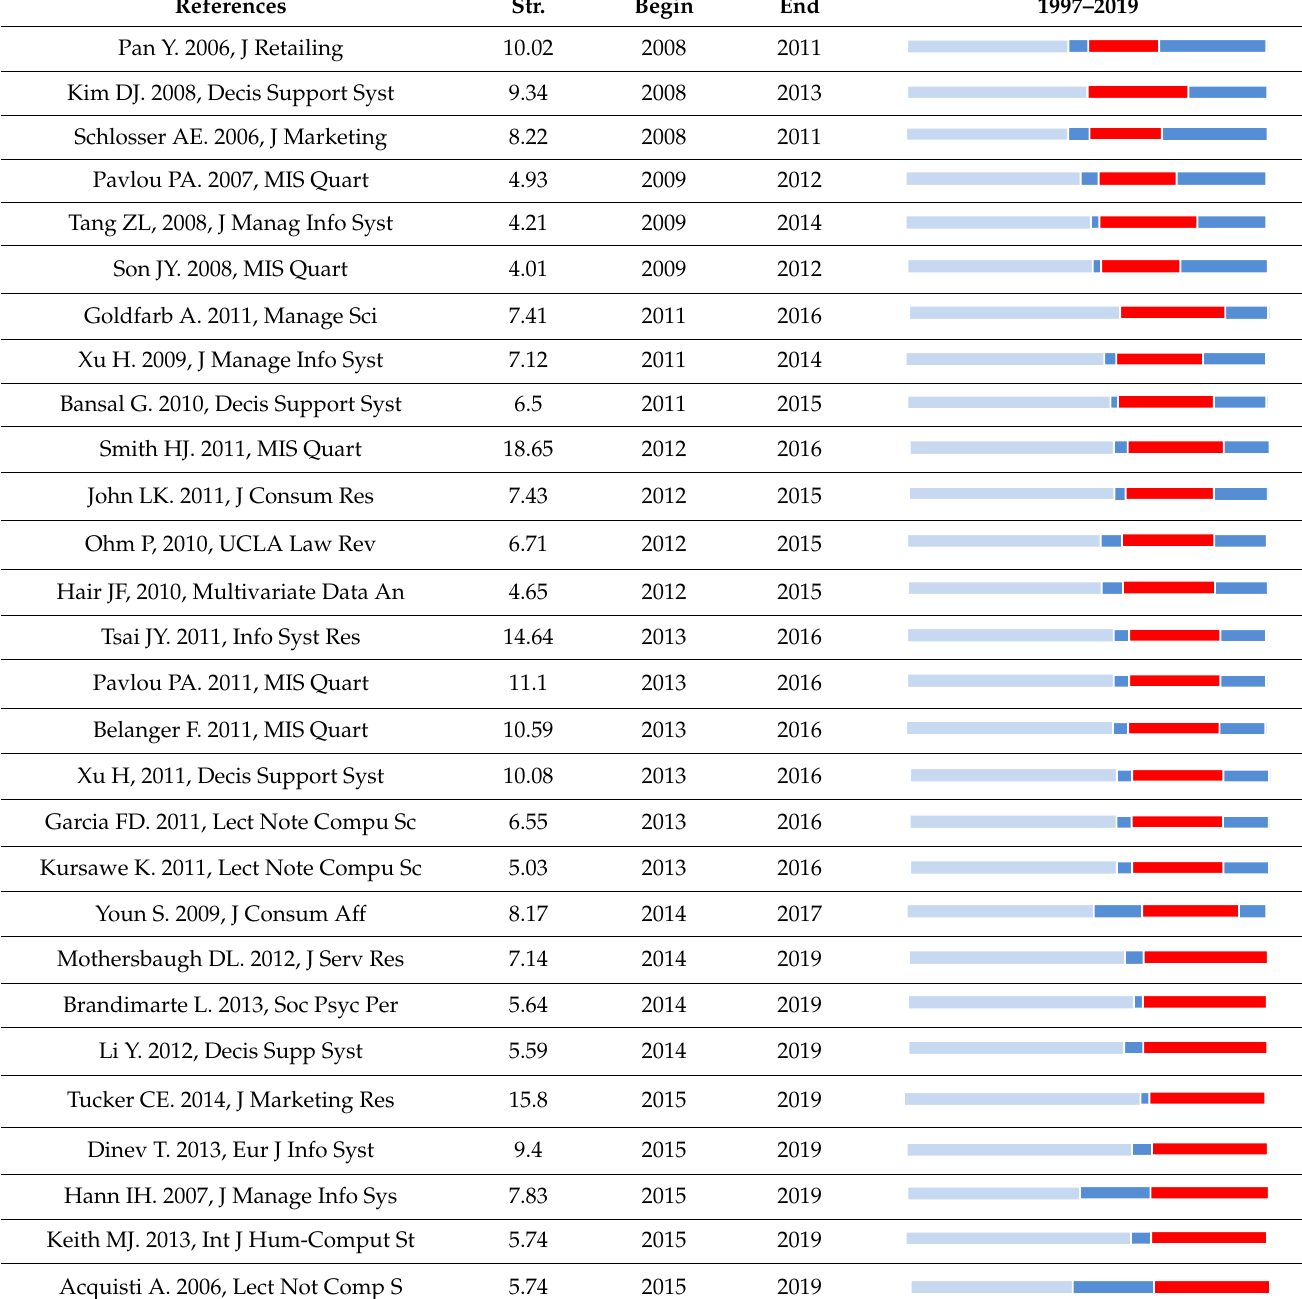
13 Table 5. Top 45 references with the strongest citation bursts. References Str.